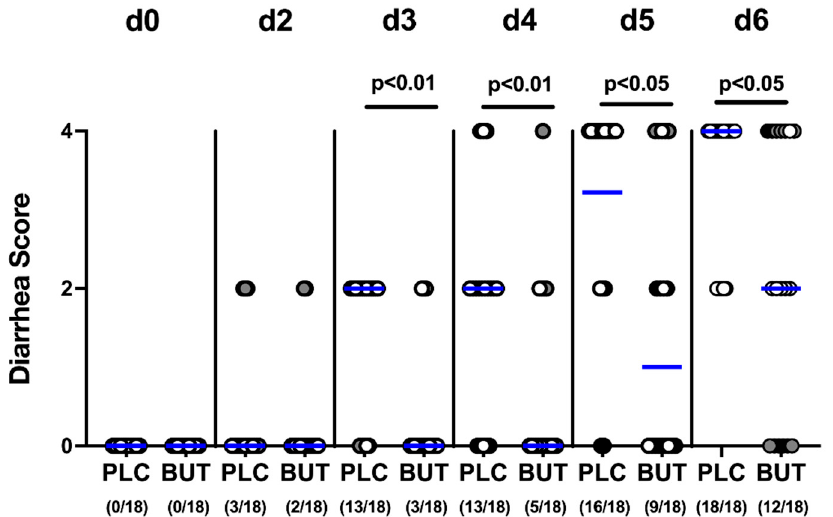
Figure 3. Diarrhea development over time in C. jejuni -infected mice upon butyrate treatment. Fol- lowing gut microbiota depletion IL-10 − / − mice were challenged with C. jejuni strain 81–176 by oral gavage on days 0 and 1. Starting from day 2 p.i., the animals were treated with either butyrate (BUT) or placebo (PLC) via the autoclaved tap water ad libitum. Diarrheal severity was assessed in each animal from day 0 to day 6 p.i. applying a clinical diarrhea score. Differently colored circles indicate data from three individual experiments. Medians (blue bar), significance levels ( p values) evaluated by the Mann–Whitney test, and the number of diarrheal mice out of the total cohort in parentheses are given.